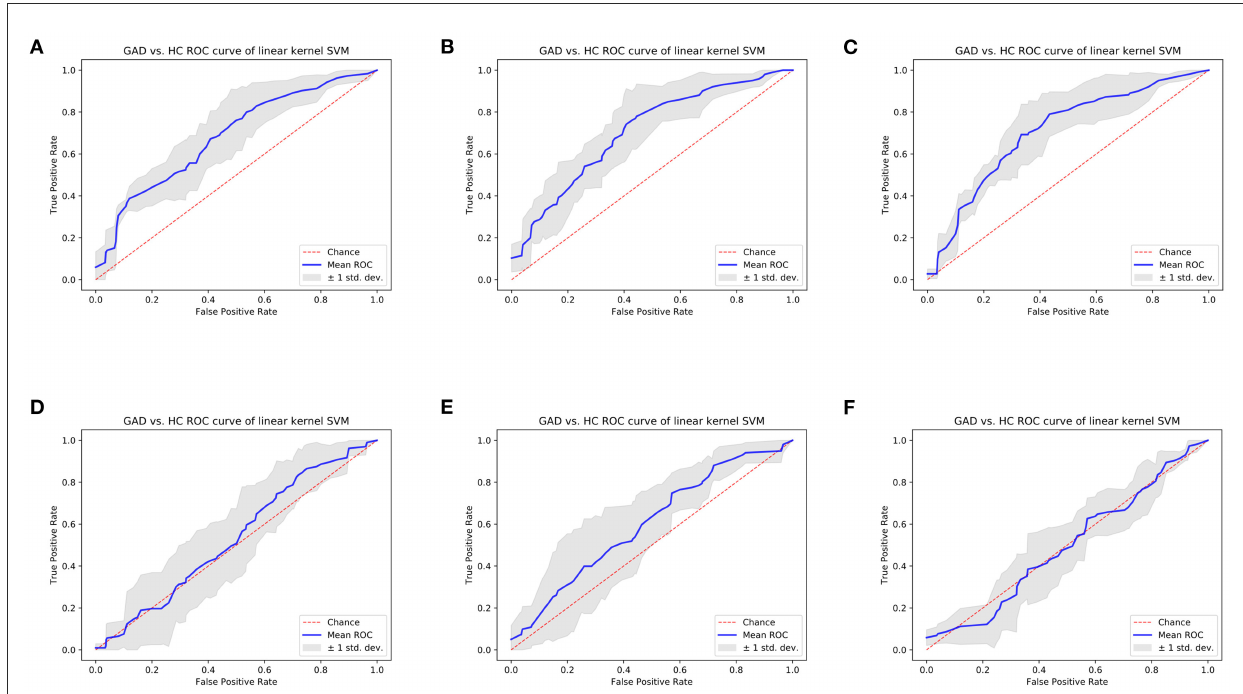
FIGURE6 Cross-validation ROC curves of linear kernel SVM model of GAD vs. HC classification task. (A) Model trained using left amygdala radiomics features; (B) model trained using right amygdala radiomics features; (C) model trained using bilateral amygdala radiomics features; (D) model trained using left amygdala volume; (E) model trained using right amygdala volume; (F) model trained using bilateral amygdala